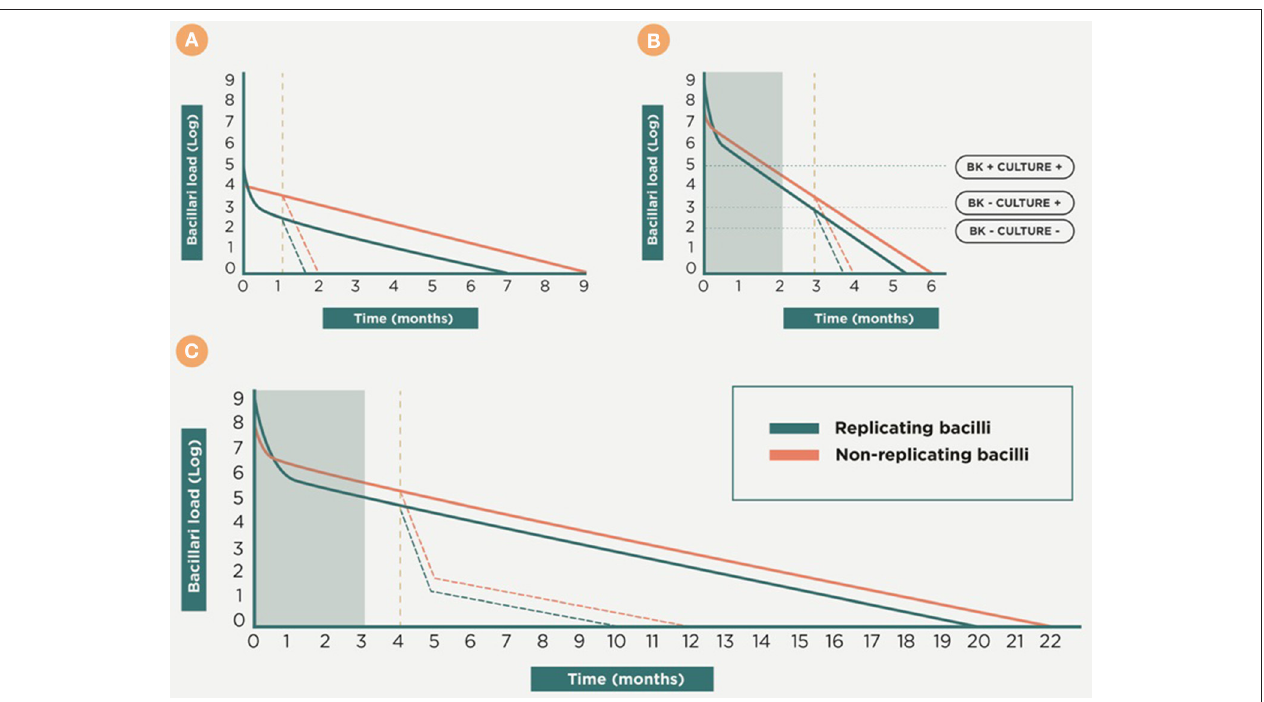
FIGURE 8 | Therapeutic vaccination as coadjuvant for chemotherapy. This is a theoretical approach to the dynamics of the bacillary concentration during chemotherapy and the influence of vaccination as a coadjuvant. Initially, the early bactericidal activity induces a massive reduction in the bacillary load by killing replicating bacilli (R-Mtb). Subsequently, non-replicating bacilli (NR-Mtb) dominate and are the responsible for the reinfection process and the appearance of R-Mtb during chemotherapy (Muñoz-Elías et al., 2005; Cardona, 2006b). The purple dotted line shows a proposal of the time-point to introduce the therapeutic vaccination, once a drastic reduction of the bacillary load is obtained and the NR-Mtb becomes the majority population. From there, the evolution of R-Mtb (green) and NR-Mtb (red) is also drawn in dotted lines to show the added bactericidal effect. Panel (A) shows the treatment of LTBI with isoniazid. Panels (B,C) shows the treatment of active TB, considering one of the worse cases (i.e., with a bacillary load of 9 logs), in sensitive and multidrug resistant (MDR) TB, respectively. In both cases the gray box shows the initial intensive phase period of